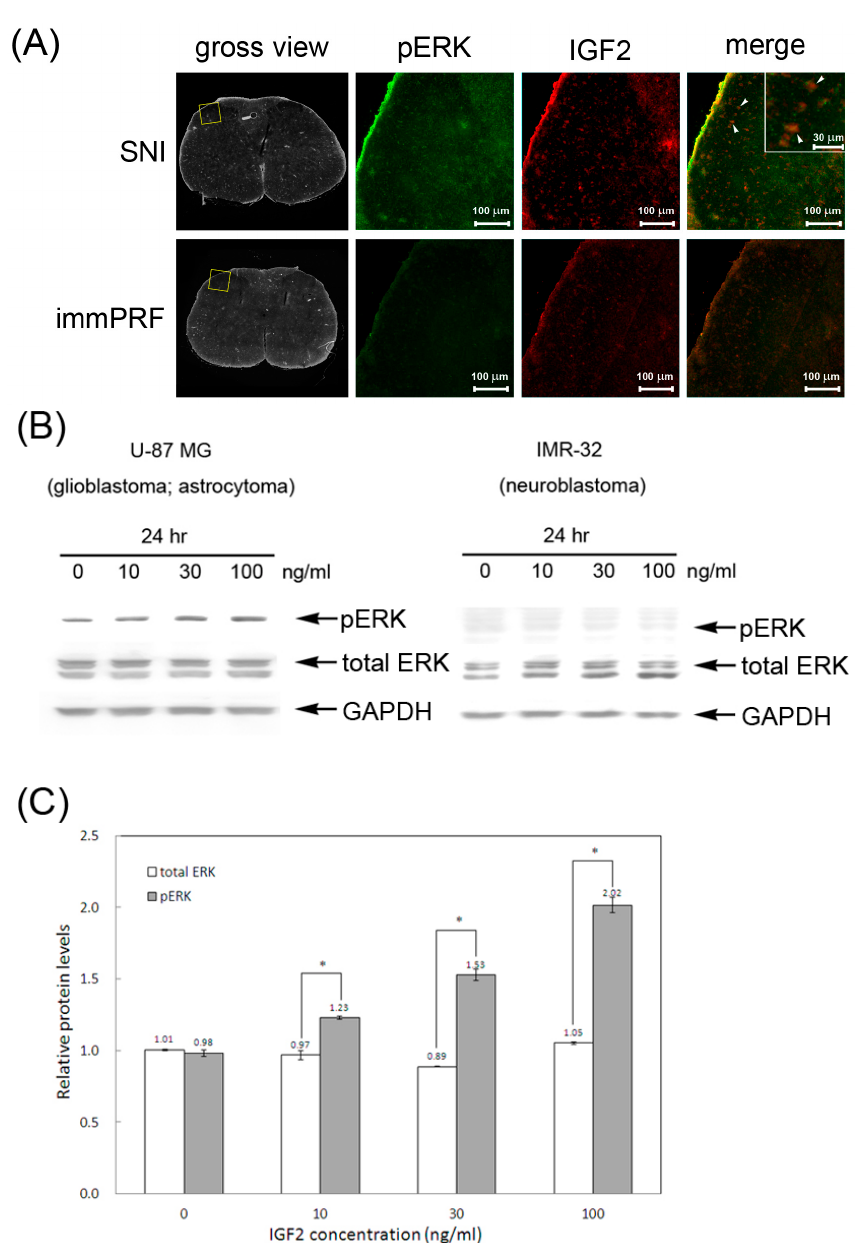
Figure 4. Correlation of phosphorylated ERK and IGF2. ( A ) In situ immunofluorescent staining of phosphorylated ERK and IGF2 in spinal cords of rats after SNI or SNI + immPRF treatment. The blank square in the gross anatomical views indicates the dorsal horn region used to illustrate the positive immunoreactive signals indicating phosphorylated ERK (pERK, green) and IGF2 (red). The gross views were taken by visible light. White arrowheads show the merged pERK and IGF2 signals. Scale bars = 100 μ m; ( B ) Immunodetection of total and phosphorylated ERK in U-87 MG and IMR-32 cells. The astrocytoma cells, U-87 MG (HTB-14), and neuroblastoma cells, IMR-32, were treated with various amounts of IGF2 (from 0 to 100 ng/mL). The total ERK protein and its phosphorylated form were detected with anti-ERK and anti-pERK antibodies, respectively. GAPDH was used as an internal control; ( C ) Relative quantitation of total and phosphorylated ERK of U-87 MG cells. The relative protein levels were determined by normalizing their expression to that of GAPDH through densitometric analyses. An independent t test was conducted to analyze two or three independent experiments. pERK, phosphorylated ERK. Blank bar, total ERK; grey bar, pERK. * p < 0.05.